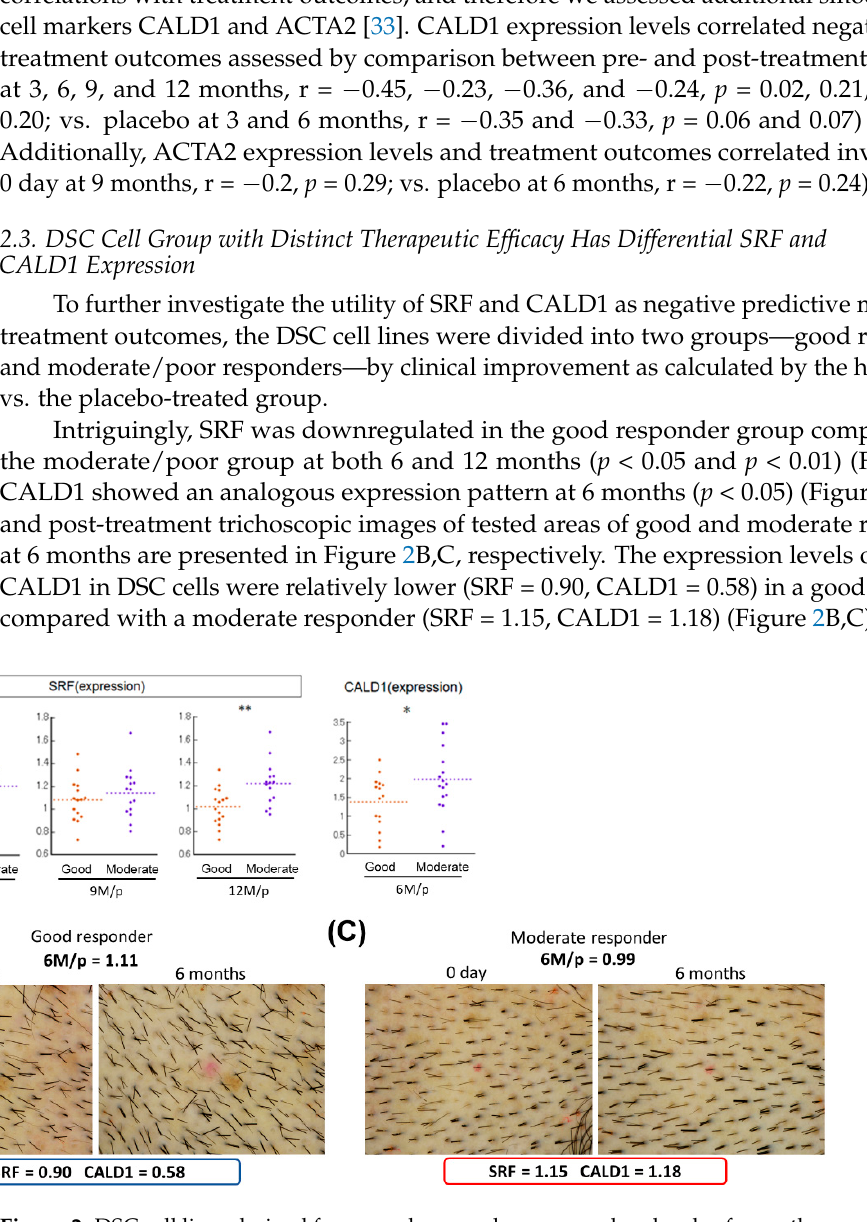
Figure 2. DSC cell lines derived from good responders express low levels of smooth muscle cell markers SRF and CALD1. ( A ) Relative expression levels of SRF and CALD1 in good and moderate/poor responder groups. Expression levels were normalized to GAPDH and the results are expressed as the mean ± S.D. Subdivision intoeach group was based on the treatment outcome score at indicated months vs. placebo at 6, 9, and 12 months (6 M/p, 9 M/p, and 12 M/p). Student’s t -test was applied for comparisons. * p < 0.05, ** p < 0.01. Pre- and post-treatment trichoscopic images of tested areas of a good ( B ) and moderate/poor ( C ) responder at 6 months are shown with the treatment outcome score (6 M/p) and values of relative expression levels of SRF and